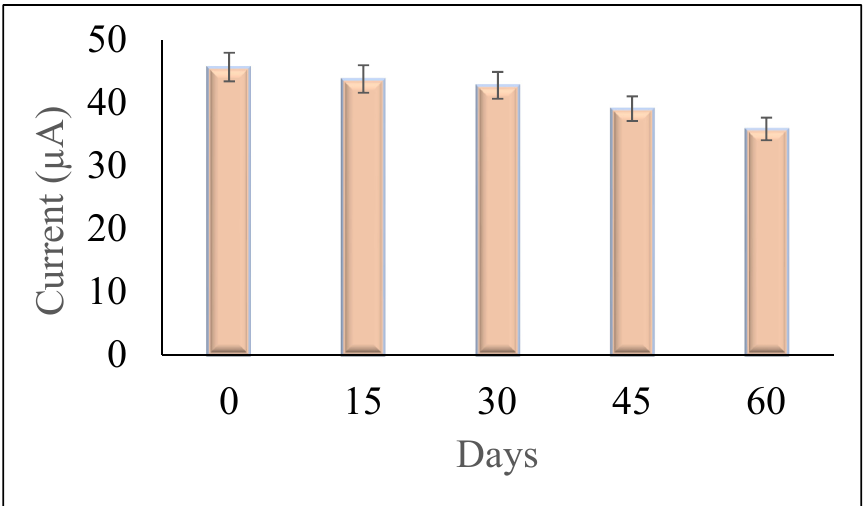
Figure 12. Demonstration of the fabricated sensing electrode’s stability over the period of 60 days.